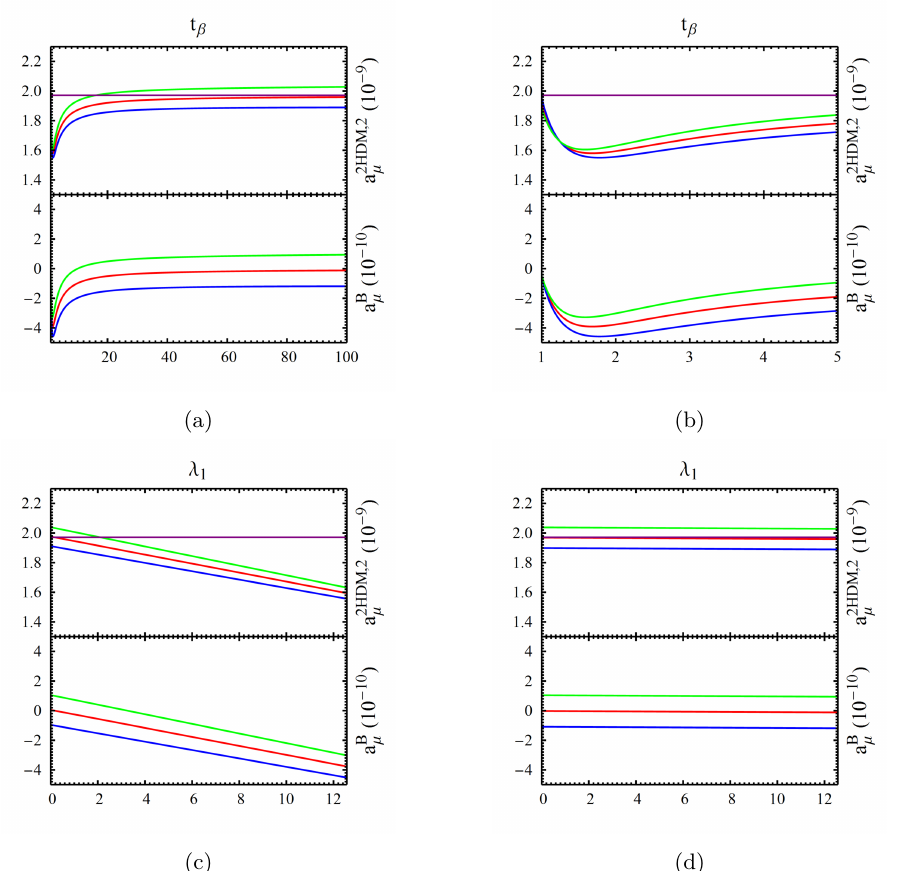
, and a B . Each µ µ